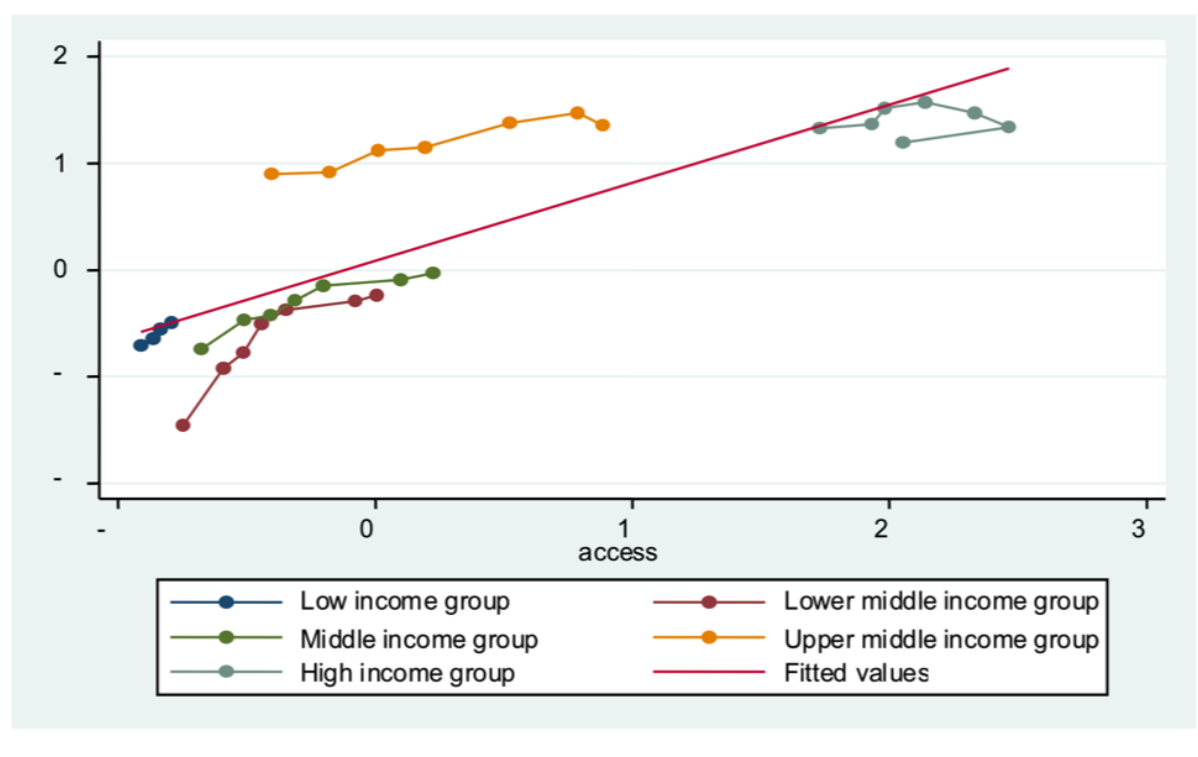
Figure 4. Impact of ICT accessibility on child immunization